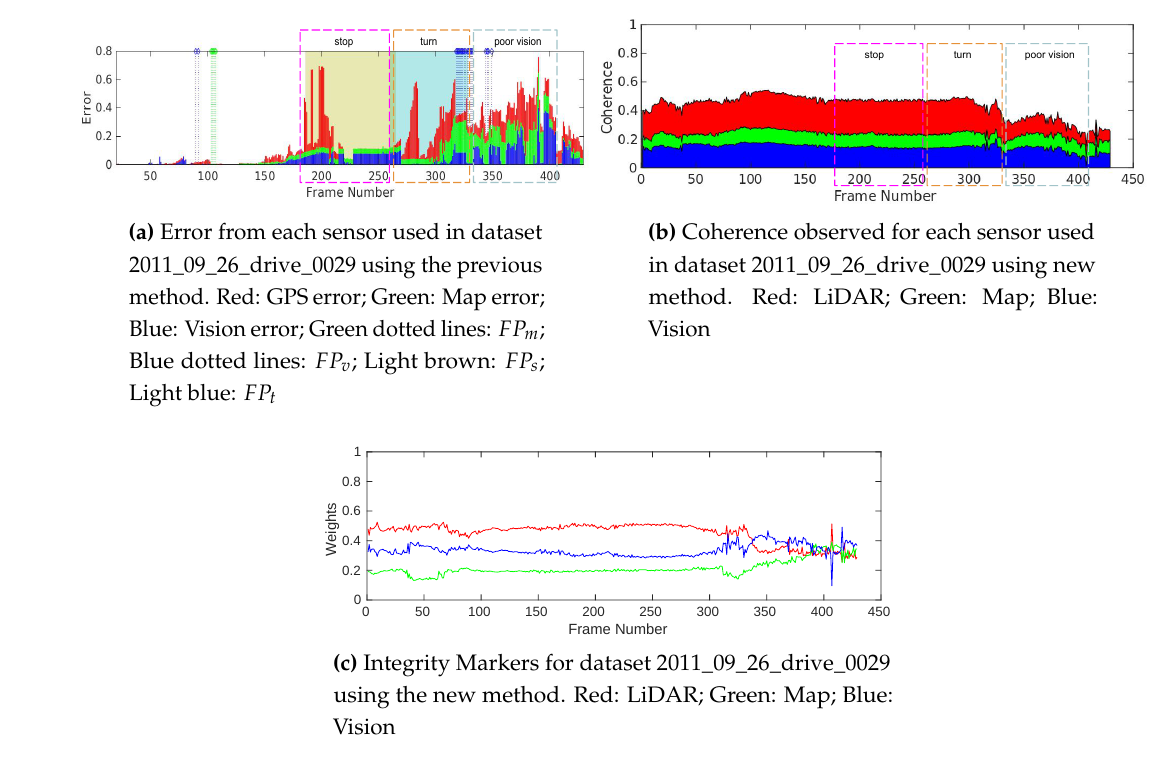
Figure 4. Comparison results of dataset 2011_09_26_drive _0029.